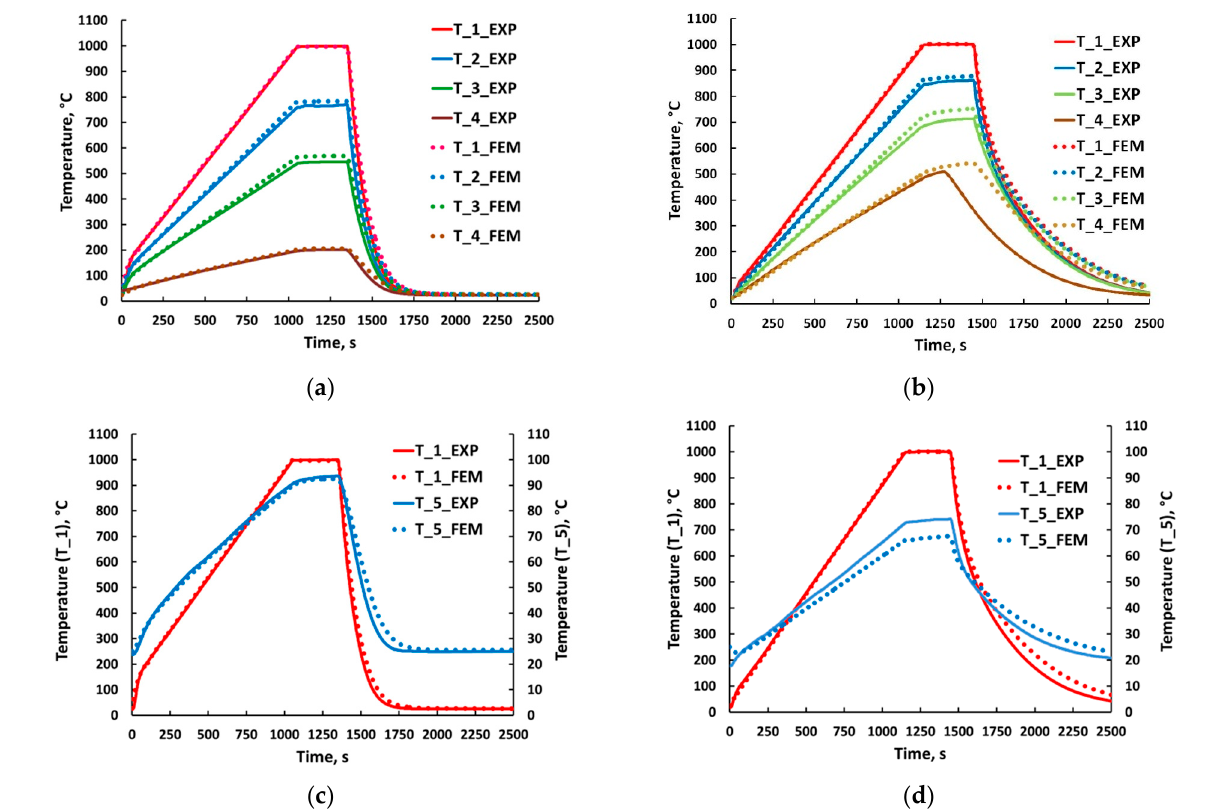
Figure 6. Temperature development as recorded by thermocouples (solid lines) and modeled by FEM (dotted lines): ( a ), ( c ) in regular setup; ( b ), ( d ) in setup with CFRC plates. T1-T3—temperature in dummy; T4—temperature in graphite spacer; T5—temperature in electrode.